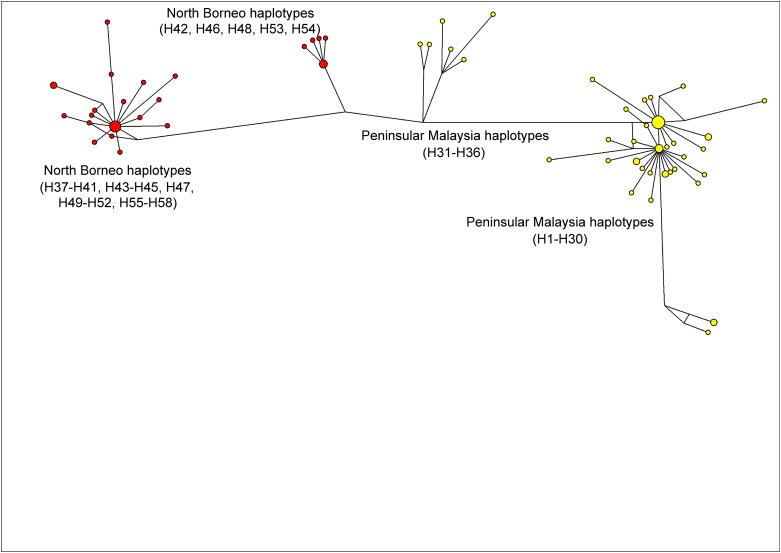
Median Joining network of PkγRII haplotypes.The network shows geographical clustering of PkγRII haplotypes from Peninsular Malaysia (yellow) and North Borneo (red). Note that haplotypes from each region are divided into two subgroups.